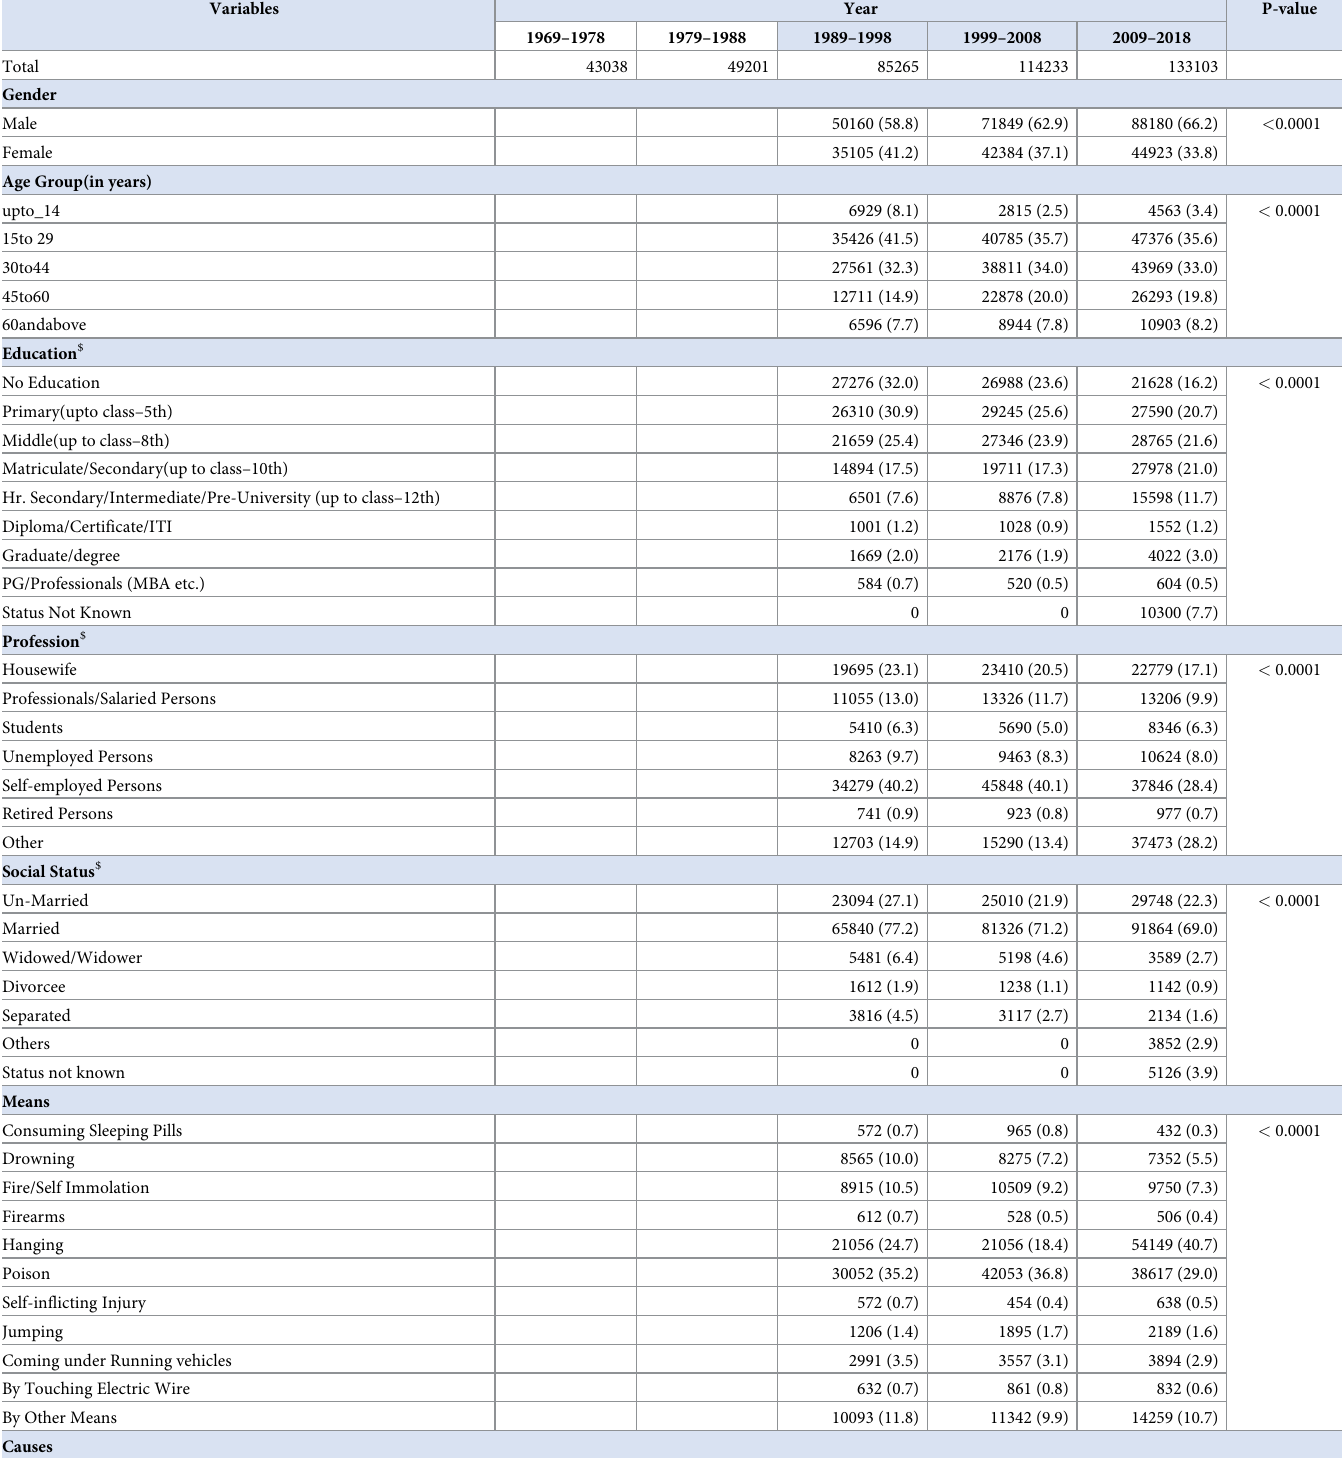
Table 1. Distribution of different attributes along with the average decadal trend of suicides.